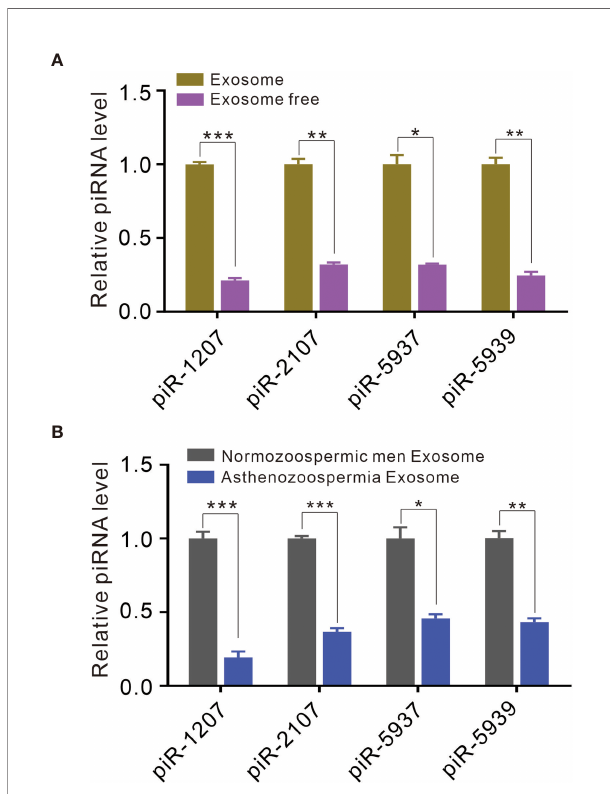
FIGURE 2 | Exosomes contain piRNAs and differential presence of piRNAs between asthenozoospermia patients and normozoospermic men. (A) Quantitative RT-PCR analysis of piR-1207, piR-2107, piR-5937 and piR- 5939 in exosomes and exosome-free seminal plasma. (B) Quantitative RT- PCR analysis of piR-1207 , piR-2107 , piR-5937 and piR-5939 in exosomes from asthenozoospermia patients and normozoospermic men. *p < 0.05; **p < 0.01; ***p <